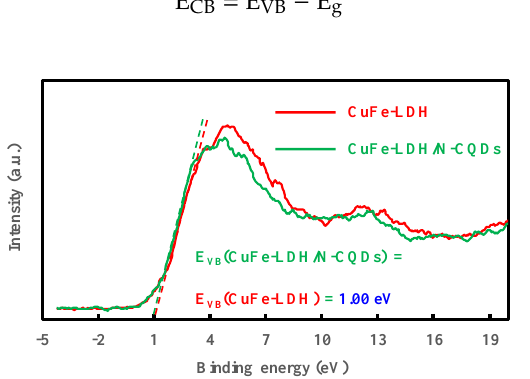
Figure 10. VB XPS spectra of CuFe-LDH and CuFe-LDH /